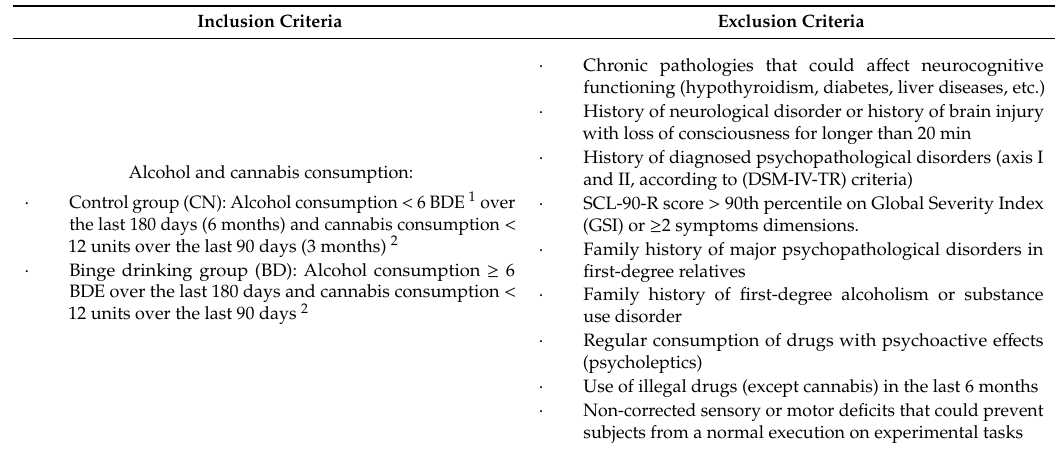
Table 1. Inclusion and exclusion criteria, based on interview.